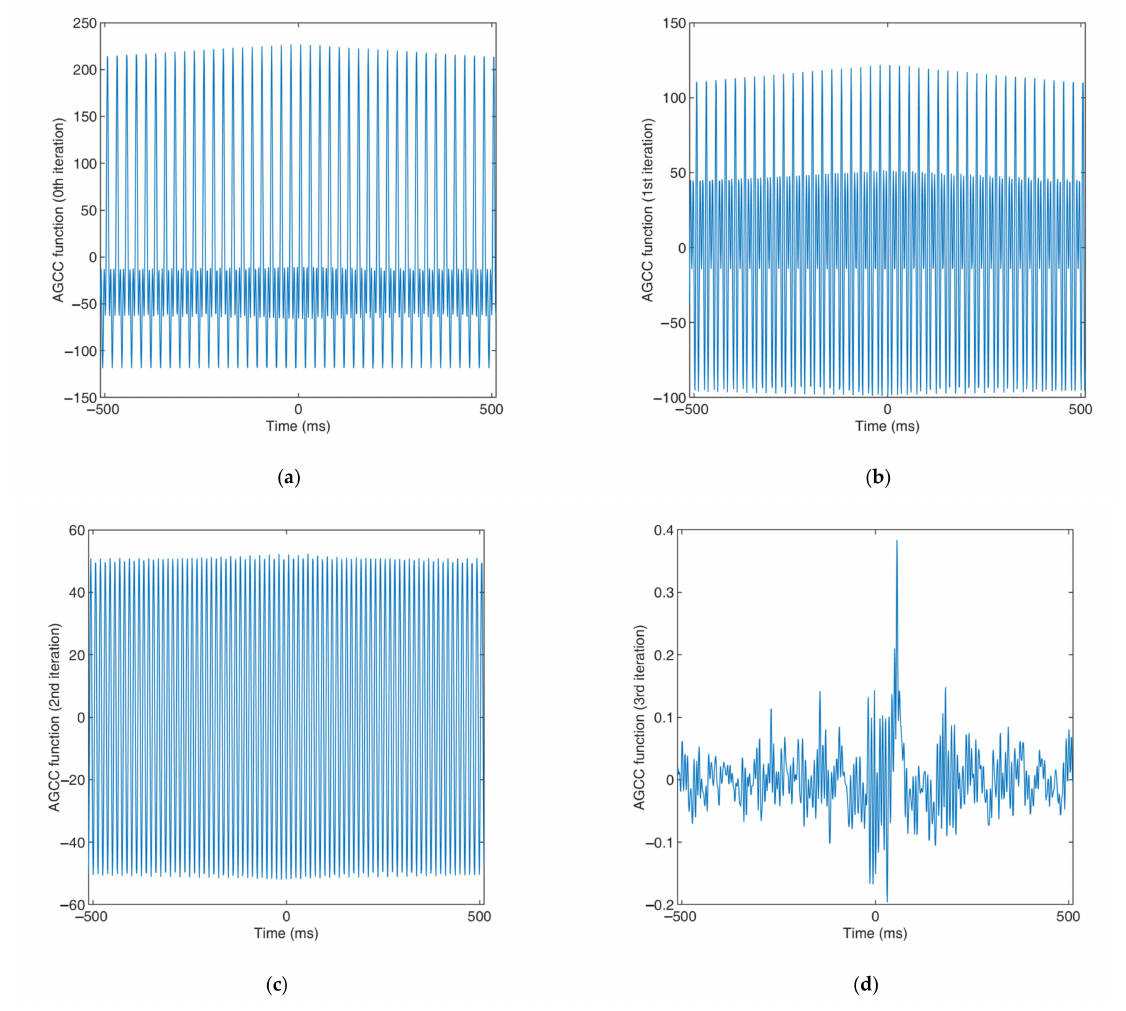
Figure 11. AGCC functions obtained by the signal with different iteration numbers: ( a ) iteration